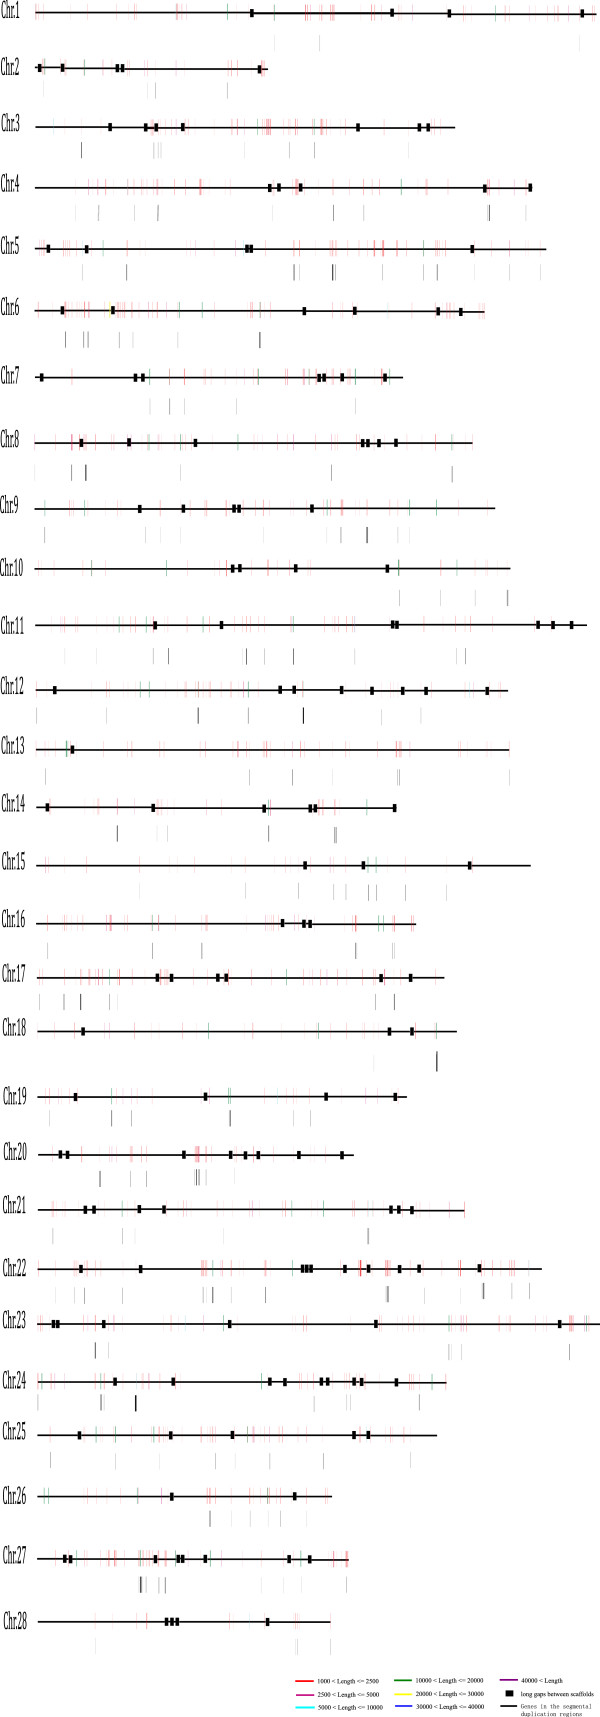
Silkworm SDs for each chromosome. Different color bars represented different lengths of SDs. The large gaps between each scaffold were shown in black rectangle. Genes embedded in each SDs were shown as black bars located under each chromosome.